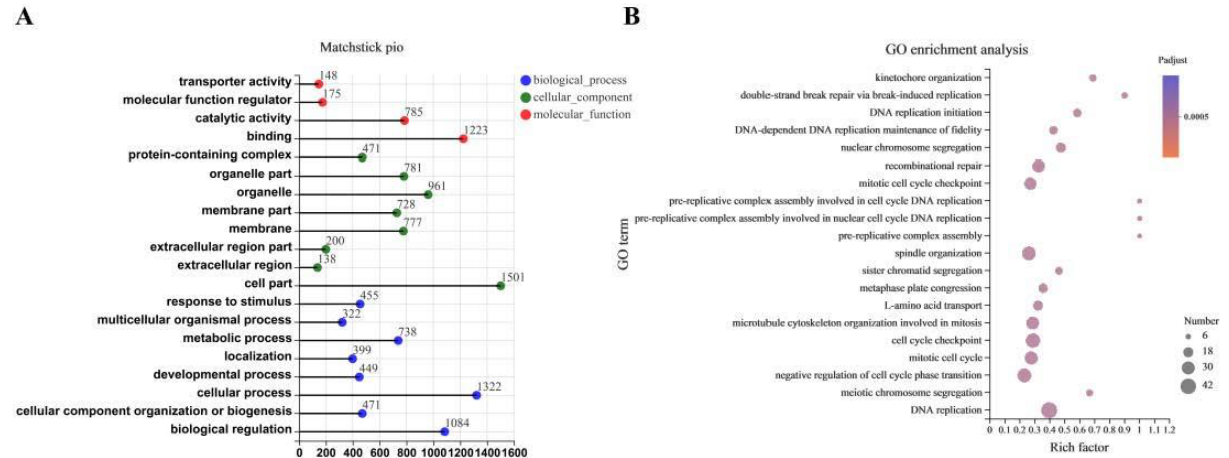
Figure 6. Effects of CDCA on GO functional annotation and enrichment analysis of IPEC-J2 cells. Matchstick Pio of GO functional annotation results for CON and CDCA groups ( A ). Scatter plot of GO functional enrichment results for CON and CDCA groups ( B ). GO, gene ontology.